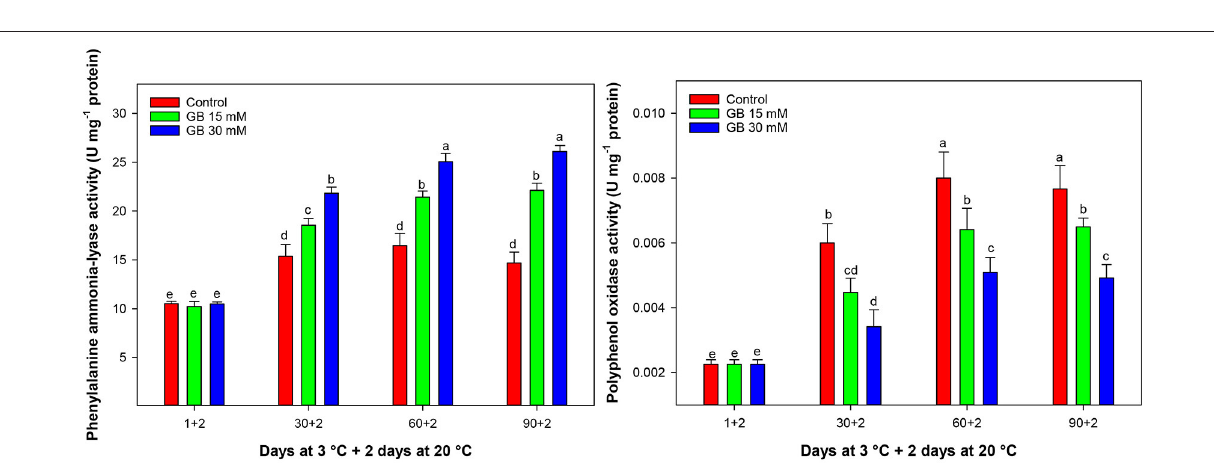
end of cold storage, the CAT activity in fruit treated with 15 and 30 mM GB was 13.53 and 23.32% higher than in control fruit,